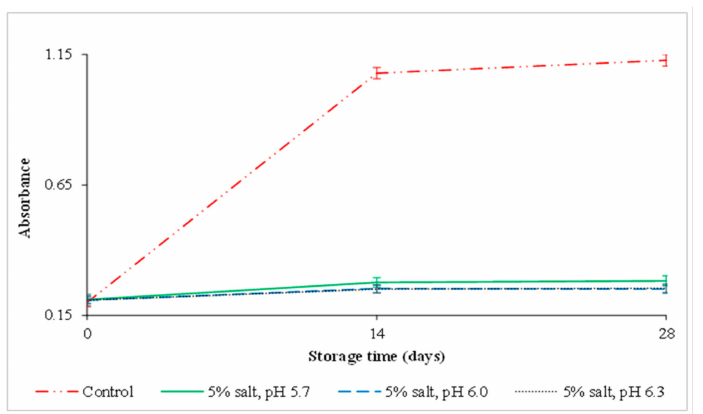
Figure 15. The effect of treatment on the turbidity of frozen-thawed liquid egg yolk. Data are presented with mean ± standard deviation.